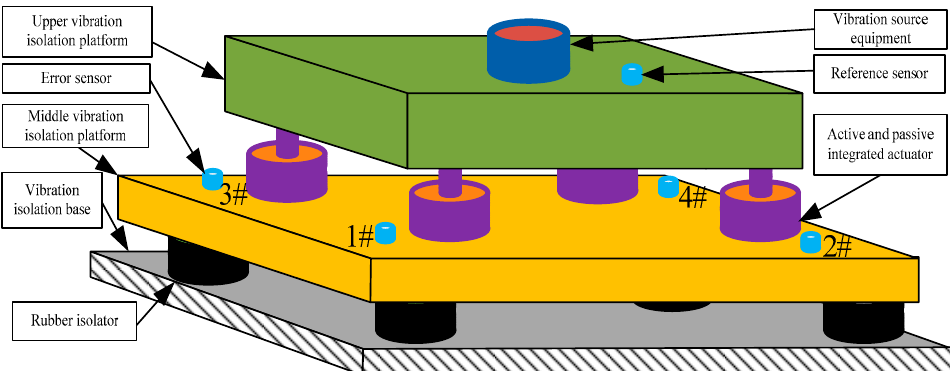
Figure 1. The multi-input and multi-output system (MIMO) system schematic diagram of a double-layer vibration isolation system.